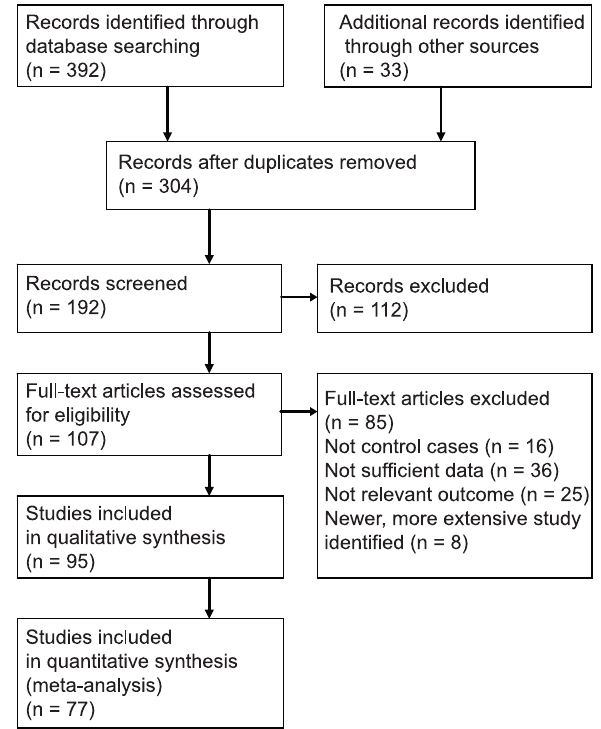
Figure 1. Flow chart showing the number of citations retrieved by database